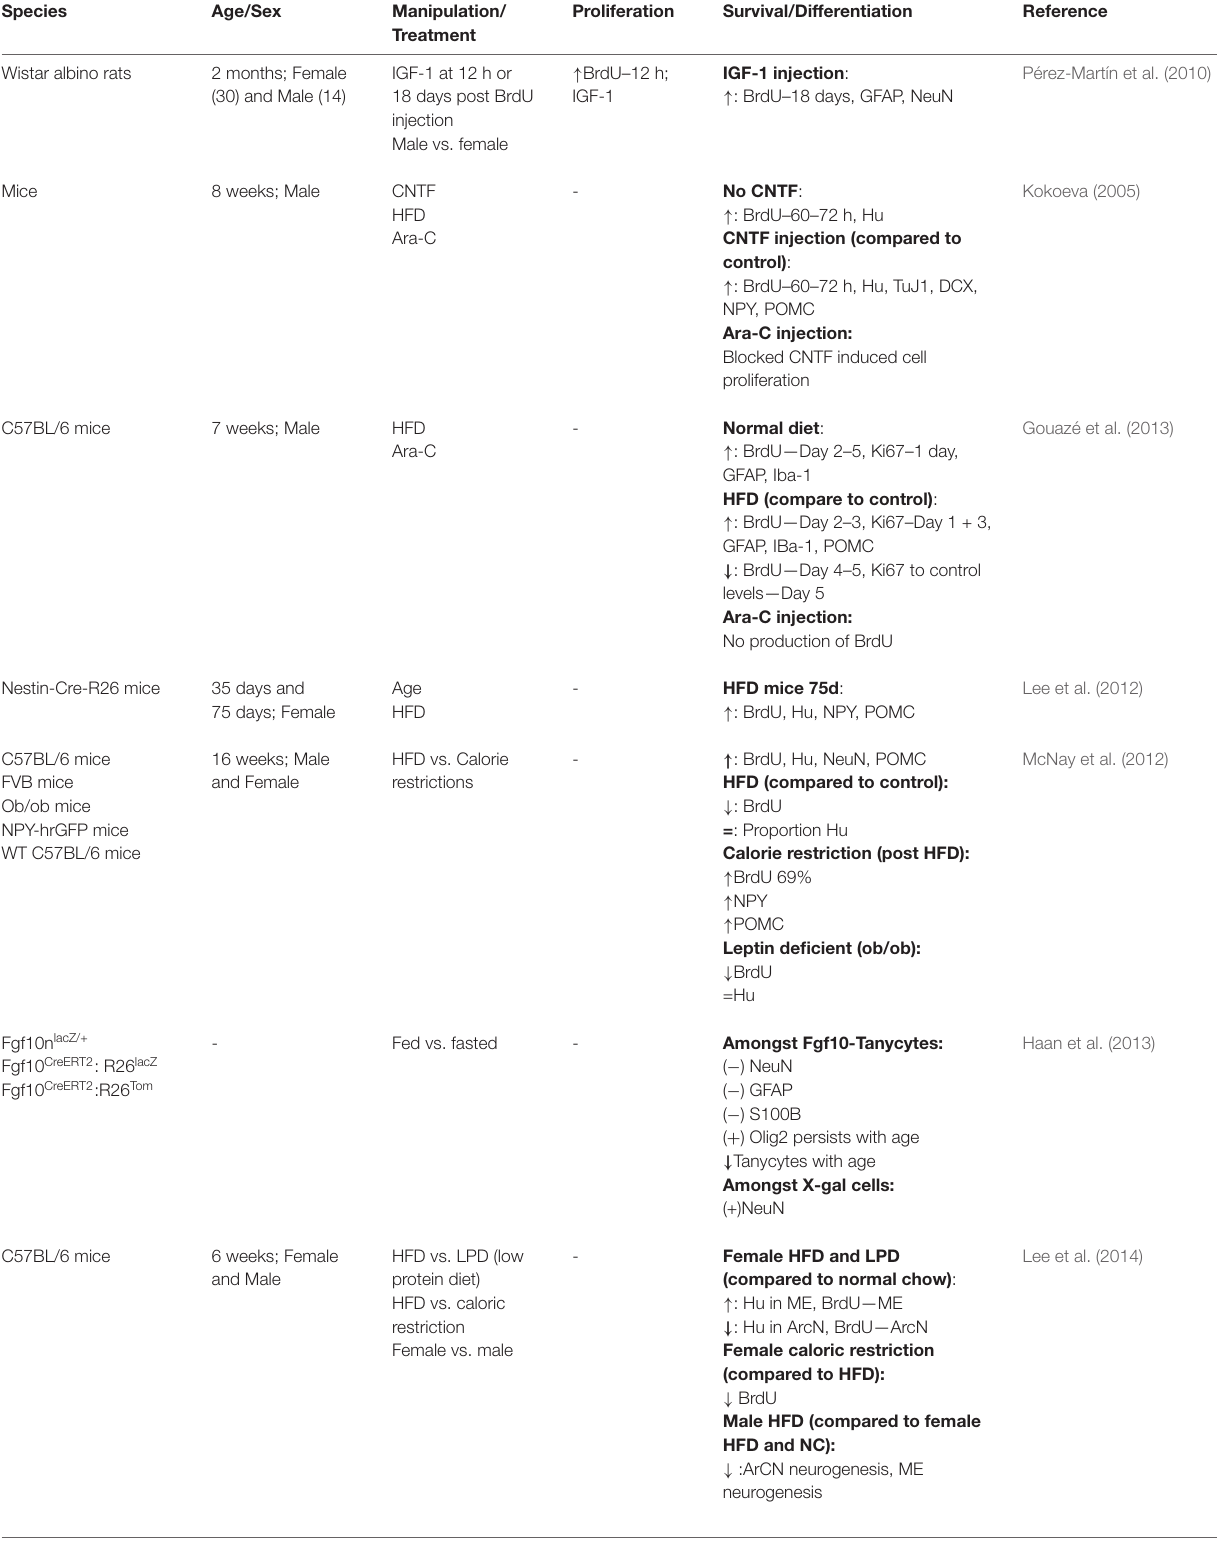
TABLE 1 | Summary of studies investigating neurogenesis in the hypothalamus. Species Age/Sex Manipulation/ Proliferation Survival/Differentiation Treatment